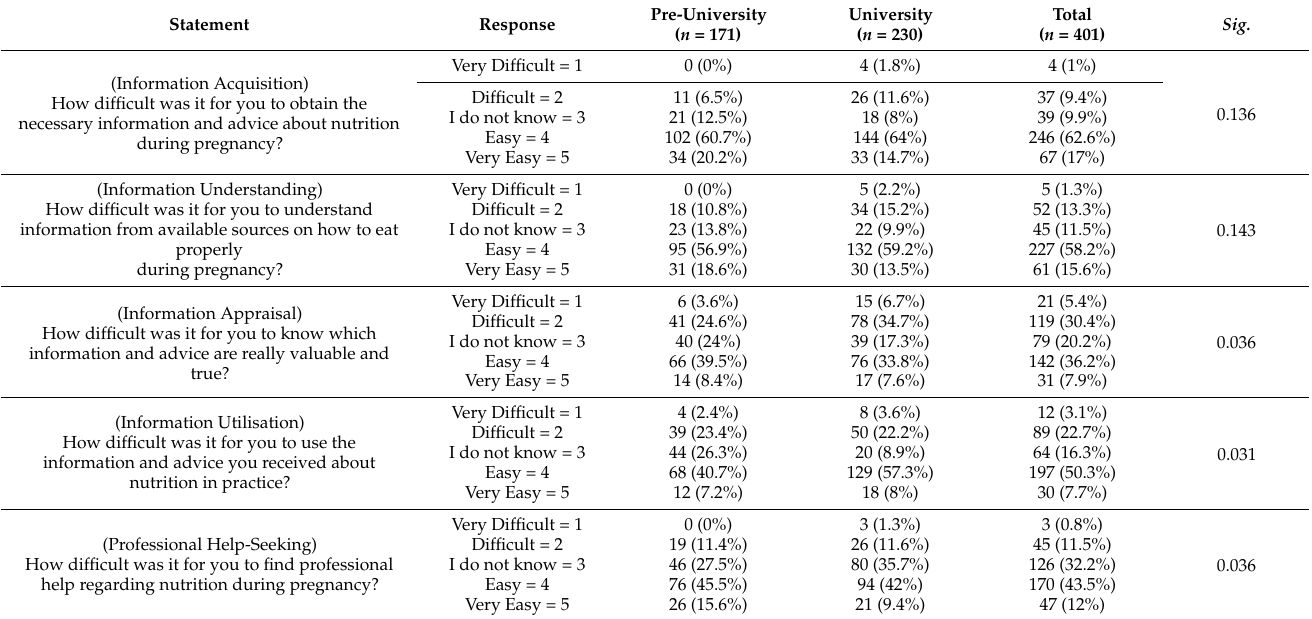
Table 6. Nutritional health literacy of pregnant women participating in the nutritional health survey, April–May 2022 ( n =